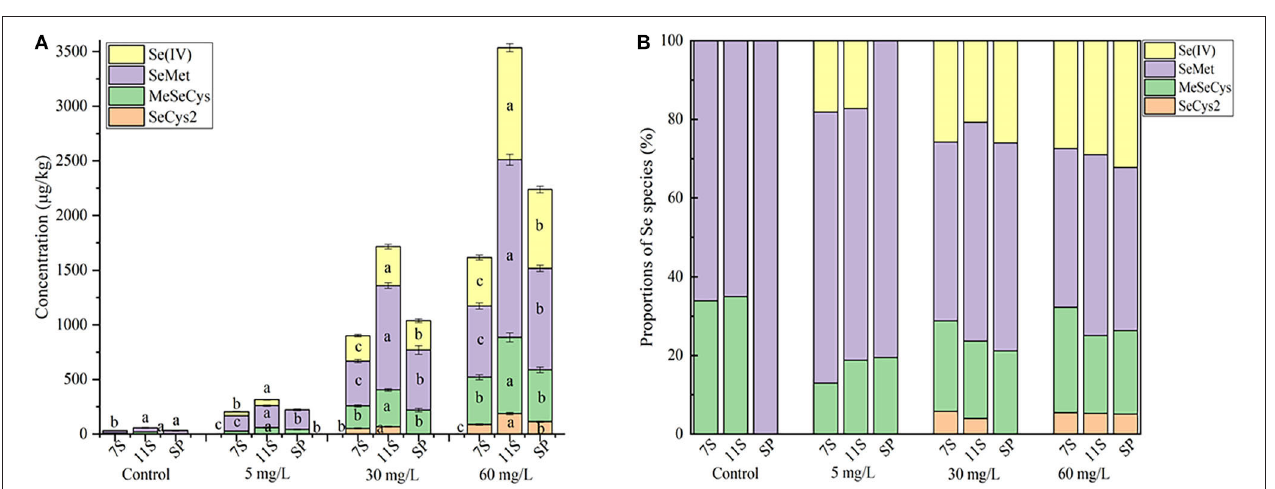
Secondary Structural Composition of Different Soybean Proteins The percentages of α -helix, β -sheet, β -turn, and random coil secondary structures of different protein fractions determined by